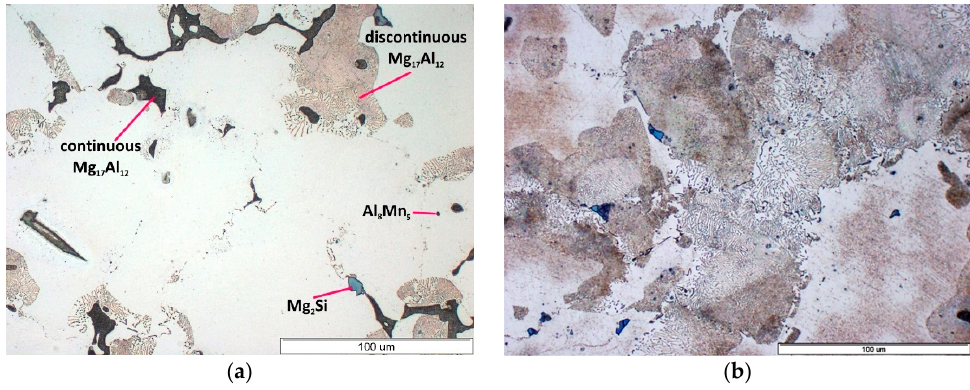
Figure 2. Microstructure of AZ91 alloy: ( a ) as-cast, ( b ) heat-treated.